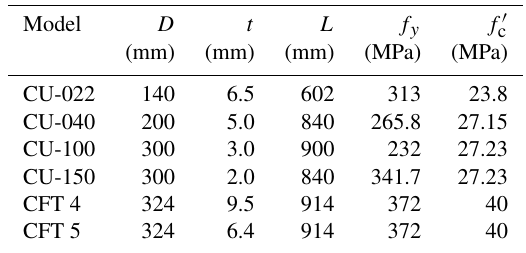
Figure 10. Modeling of a circular CFT column. Table 1. Dimensions and Material Properties of Specimens (Moon et al., 2012; Elremaily and Azizinamini,